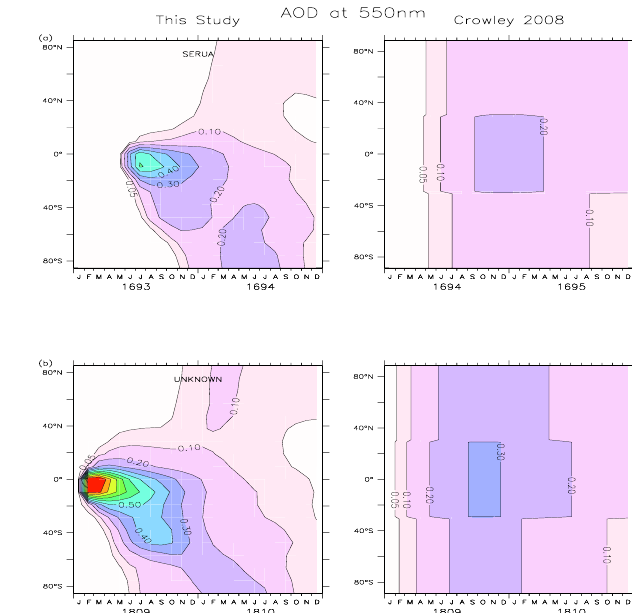
Fig. 5. Latitudinal distribution of the optical depth in VIS (550nm) for the Serua (1693) and Unkown (1809) eruptions for this study (left column) and Crowley et al. (2008) (right